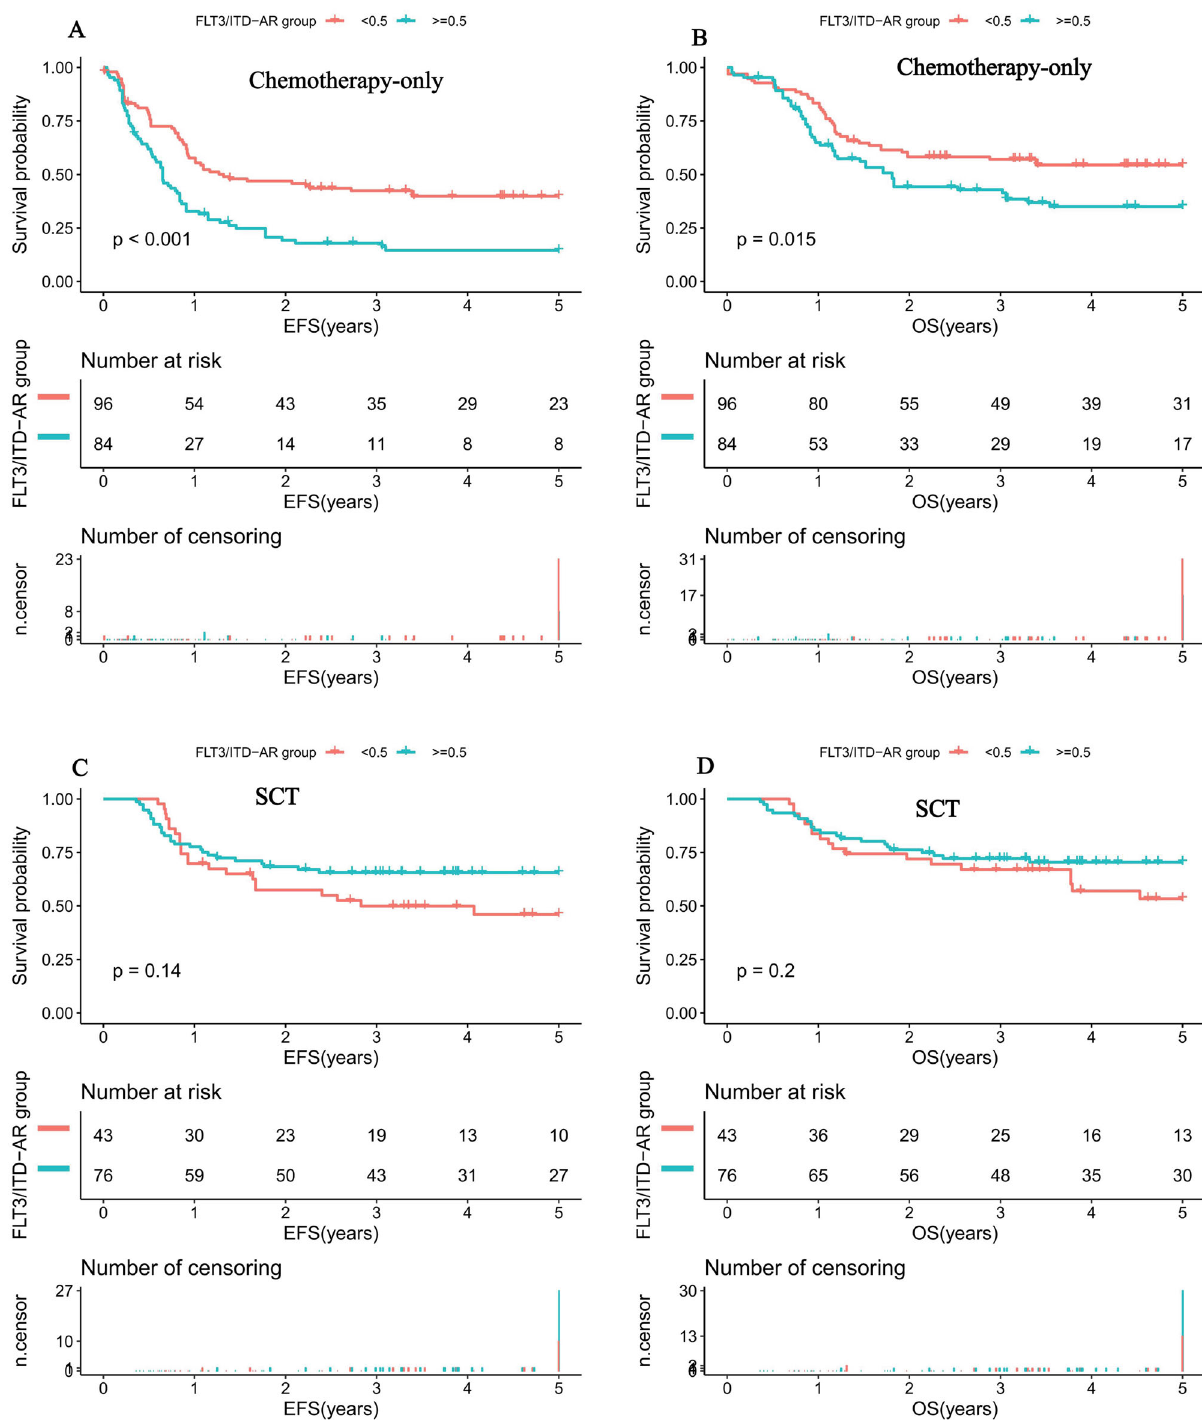
Fig. 4 Survival curves of all pediatric AML patients according to the FLT3/ITD AR and SCT status. A Probability of EFS for patients with chemotherapy- only in different FLT3/ITD AR. B Probability of OS for patients with chemotherapy-only in different FLT3/ITD AR. C Probability of EFS for patients with SCT in different FLT3/ITD AR. D Probability of OS for patients with SCT in different FLT3/ITD AR. AML acute myeloid leukemia, SCT stem cell transplantation, AR allelic ratio, EFS event-free survival, OS overall survival. EFS and OS were evaluated by the Kaplan – Meier method and compared by log-rank test. Source data are provided as a Source Data fi